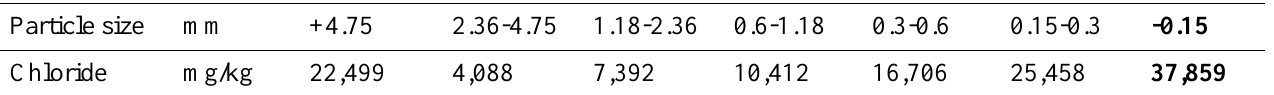
Table 2. Chloride concentration (mg/kg) of municipal solid waste incineration (MSWI) bottom ash produced in South Korea according to particle size (mm) (modified from Jo et al .